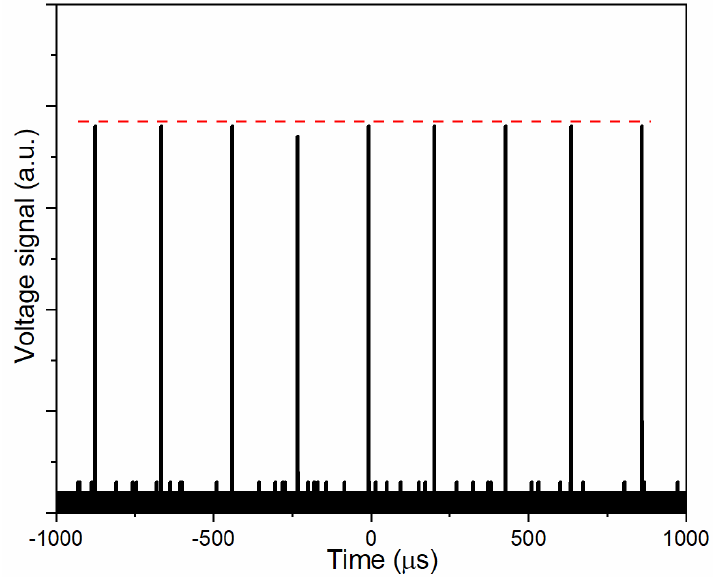
Figure 5. The voltage response as a function of time when the YBCO thin film laser detector is irradiated by laser pulses with a repetition rate of 4 kHz. The dashed line in red indicates the variation of amplitudes of different signals.